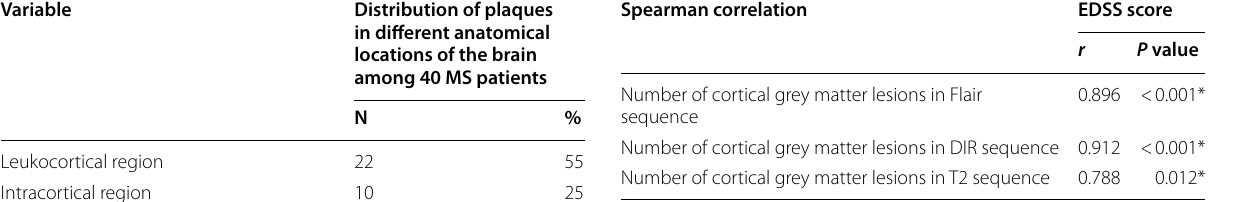
Table 6 Spearmen correlation between number of cortical grey matter lesions in DIR, T2 and Flair sequences versus EDSS